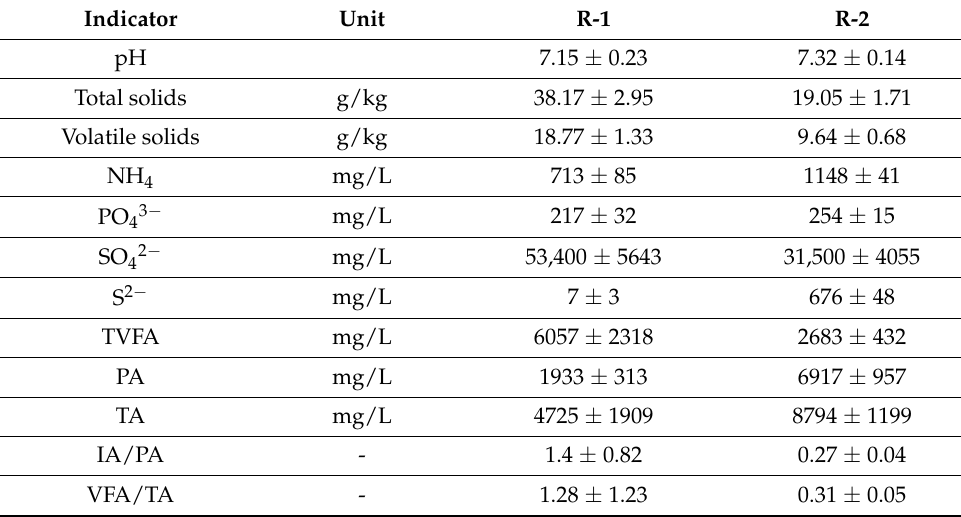
Figure 6. Changes in volatile fatty acids and alkalinity during the semicontinuous anaerobic co-digestion of ASW, IF, and MONG with SRT of 60 days (experiment R-2). Table 4. Characteristics of digestates from semicontinuous